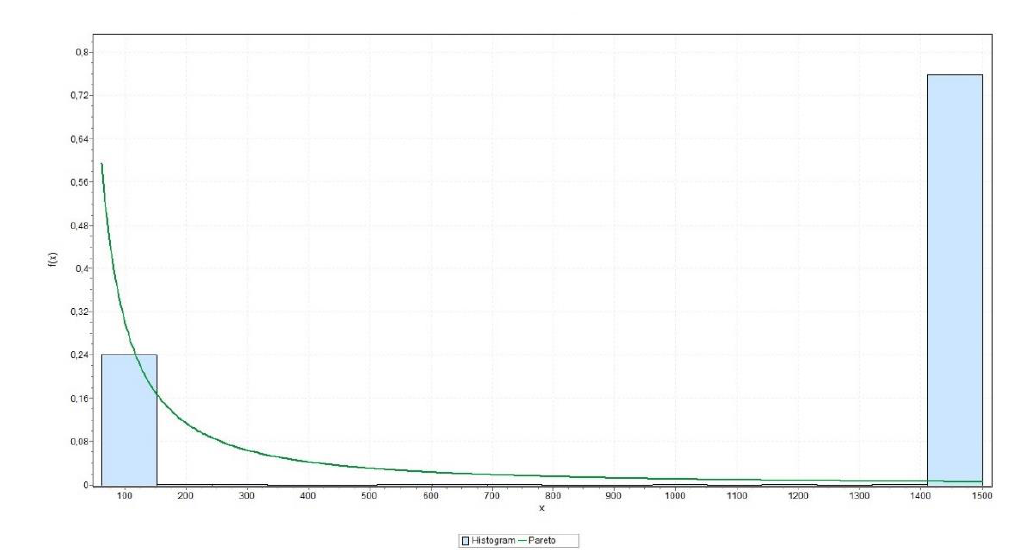
Figure 7. Pareto distribution of the lengths of the packets, the value of the parameters: α=0.41,